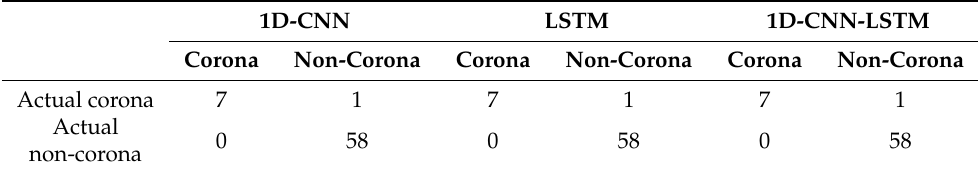
Table 8. Time domain corona fault classification output matrix for the validation phase.